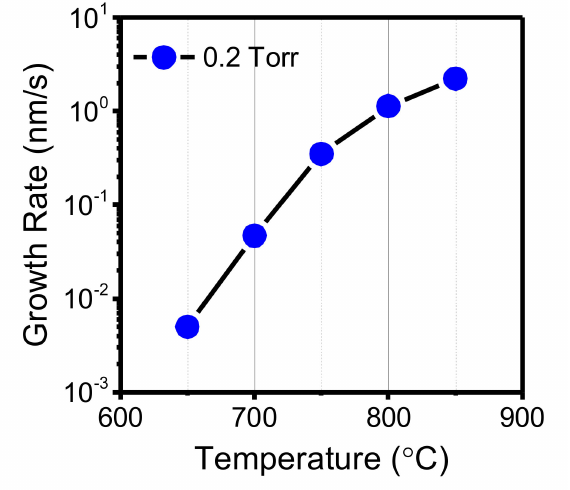
Figure 7. Growth rate as a function of deposition temperature for SiC films produced via TSCH at 0.2 torr working